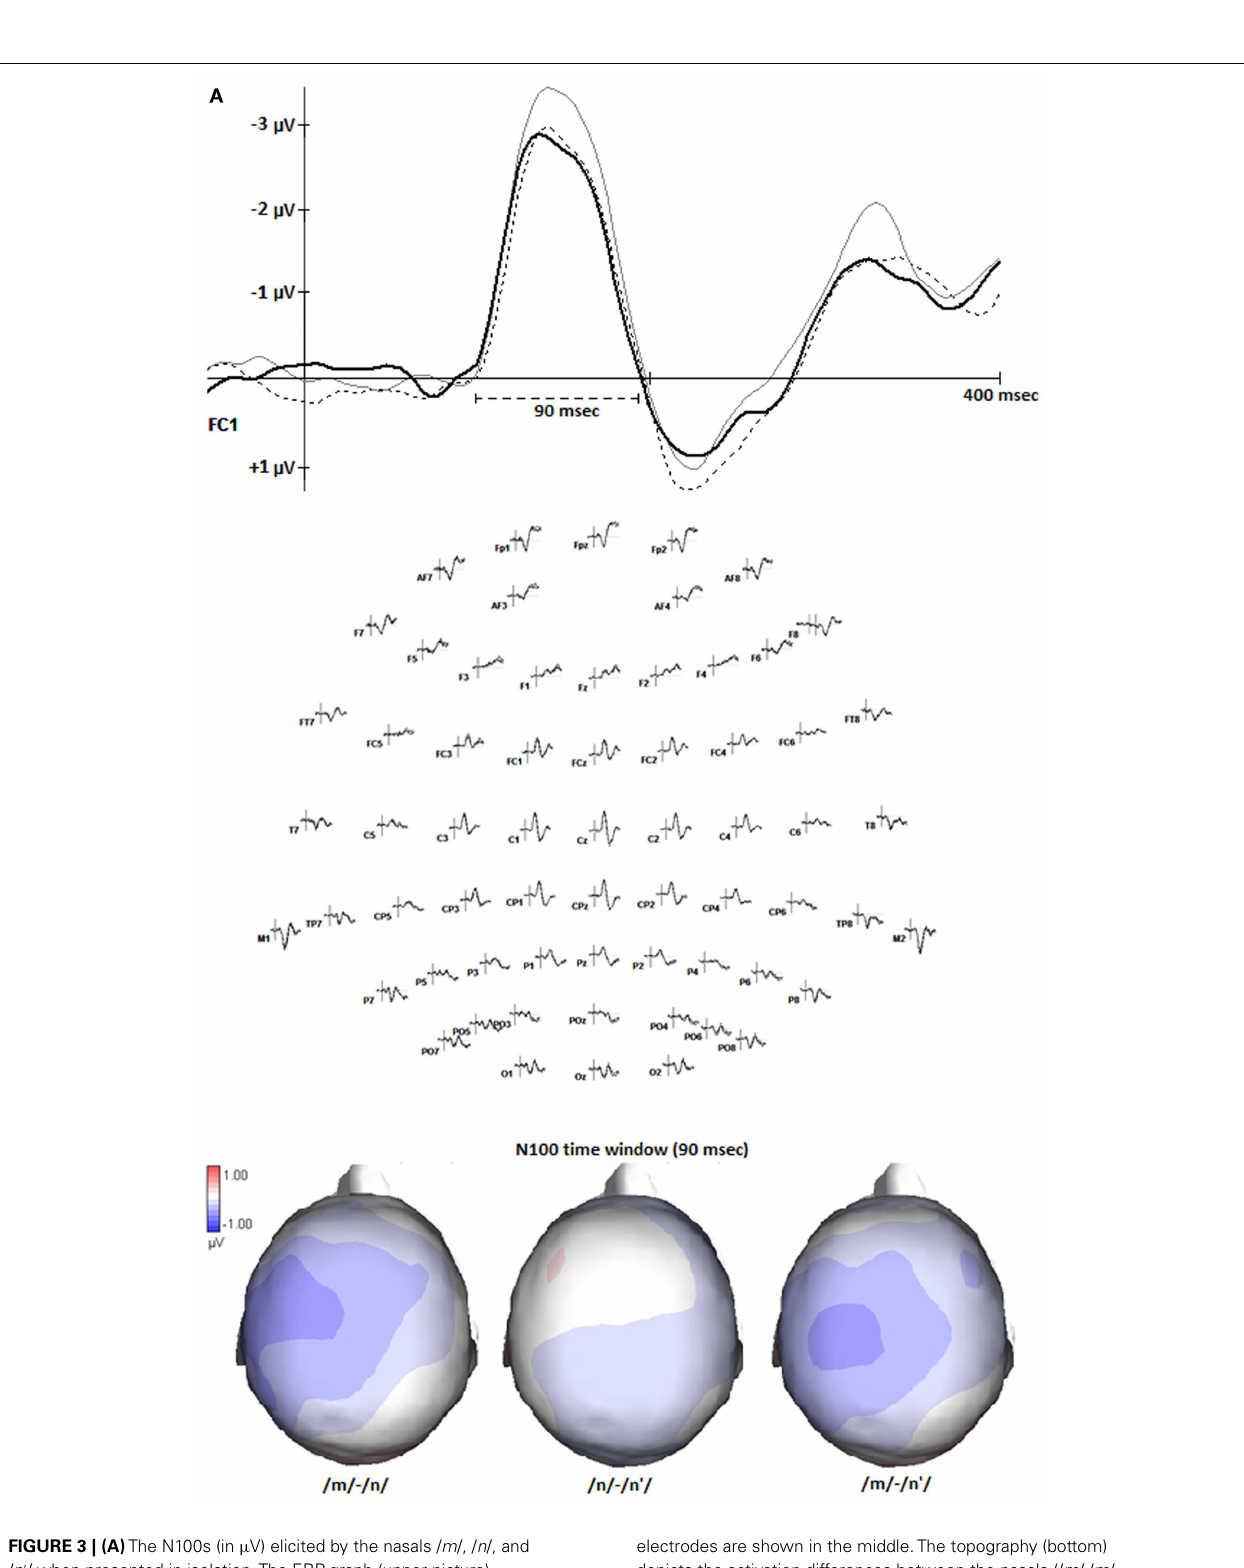
electrodes are shown in the middle.The topography (bottom) depicts the activation differences between the nasals (/ m /-/ m /, / n /-/ n (cid:48) /, and / m /-/ n (cid:48) /), averaged over the N100-time window.